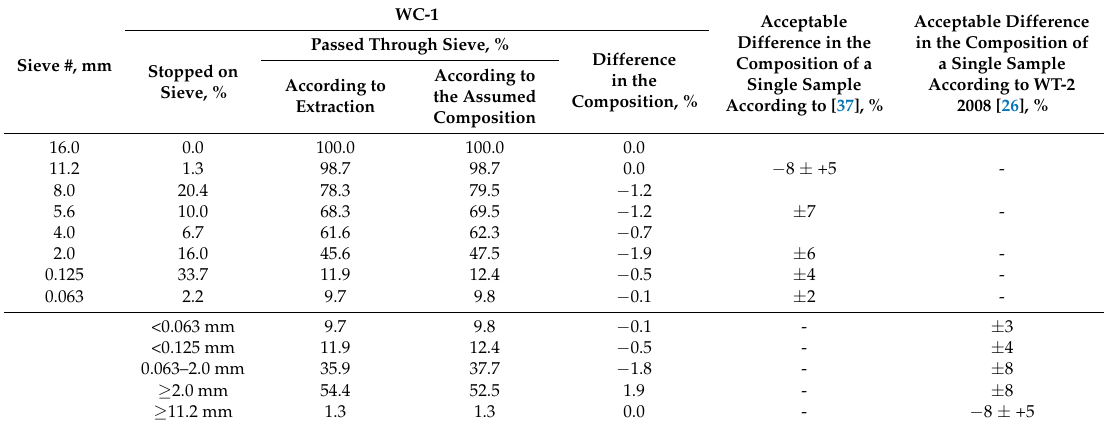
Table 8. Aggregate graining following extraction for